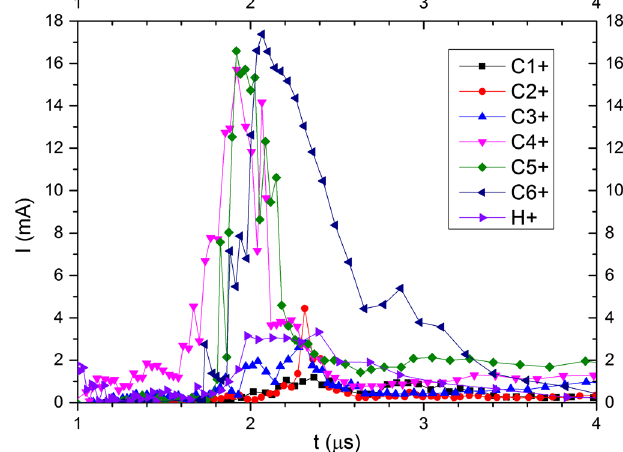
FIG. 7. Comparison of the measured and simulated E field strength in the DT section with and without the tuning.